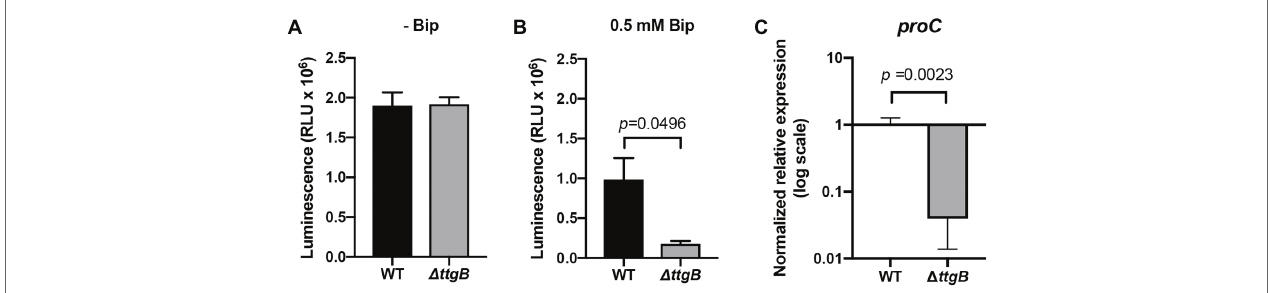
FIGURE 3 | Bipyridyl influences the metabolic state of the ttgB mutant. (A) Measurements of relative intracellular levels of ATP in cells grown in Mueller Hinton 2 medium without and (B) with 0.5 mM Bip. (C) Relative expression levels of proC in KB plus 0.5 mM Bip for wild type and ttgB strain were assessed by qRT-PCR. The target gene was normalized against the reference gene ( rpoD ) using the wild type strain as the control group. The data represent three independent